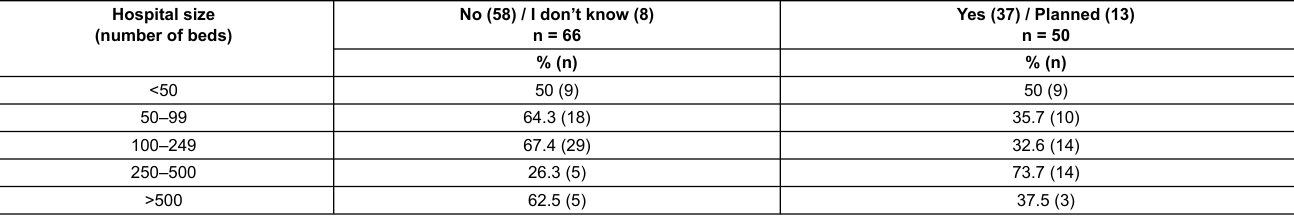
Table 6: Comparison relating hospital size to existence of guidelines (n = 116). Hospital size (number of